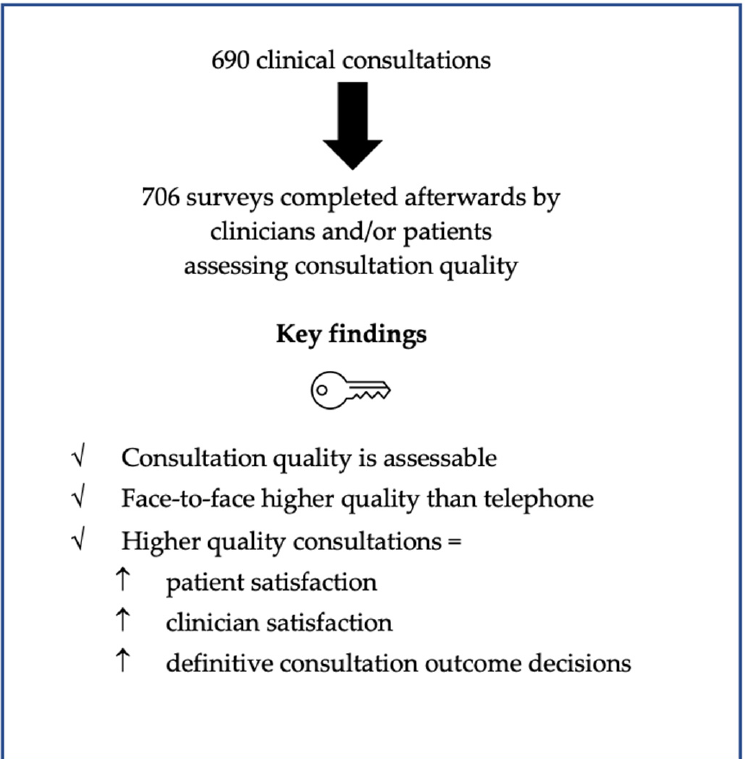
Figure 2. Key study findings.